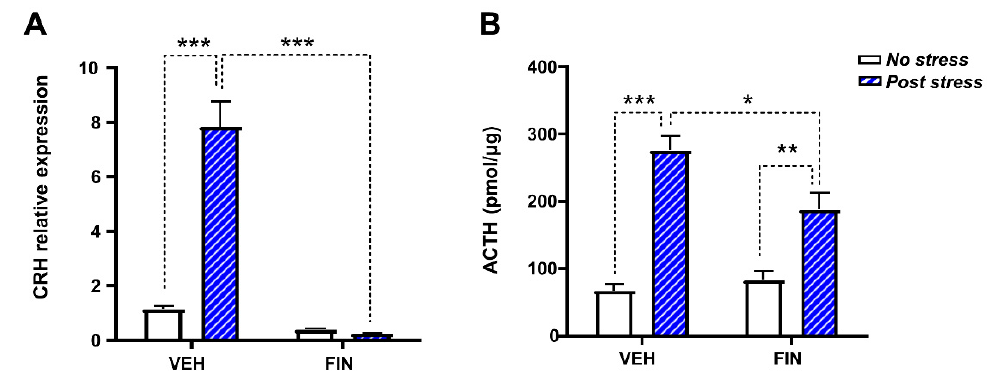
Figure 7. Finasteride (FIN) reduced stress coping behavior in the forced-swim test. In male rats, FIN increased the duration of immobility ( A ) and reduced the latency to immobility ( B ); n = 12/group. In female rats, FIN affected only the duration of immobility ( C ), but not the latency ( D ); n = 8–9/group. The depressogenic effect was not modified by gonadectomy ( E ); n = 9–11/group (GDX) ( E ). * p < 0.05, ** p 0.01, *** p < 0.001 in comparison with rats treated with vehicle (VEH); # p < 0.05 in comparison with FIN (10 mg/kg, IP). Doses of FIN are indicated in mg/kg (IP).